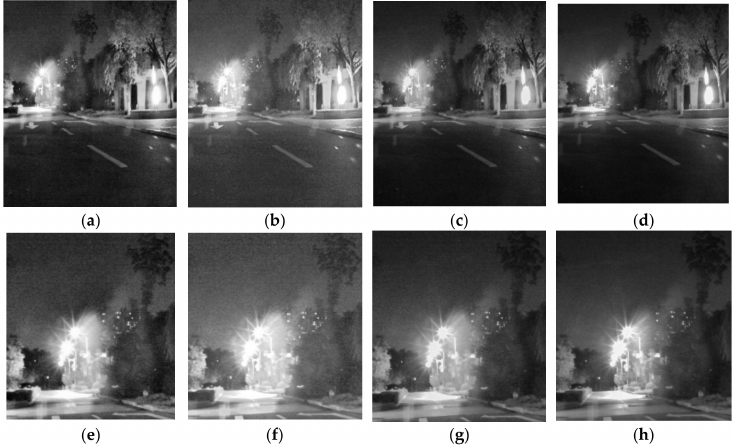
Figure 11. Comparison of different methods of outdoor images. ( a ) The fusion image of [16]. ( b ) The fusion image of [29]. ( c ) The fusion image of [15]. ( d ) The fusion image of our method. ( e ) The local image of [16]. ( f ) The local image of [29]. ( g ) The local image of [15]. ( h ) The local image of our